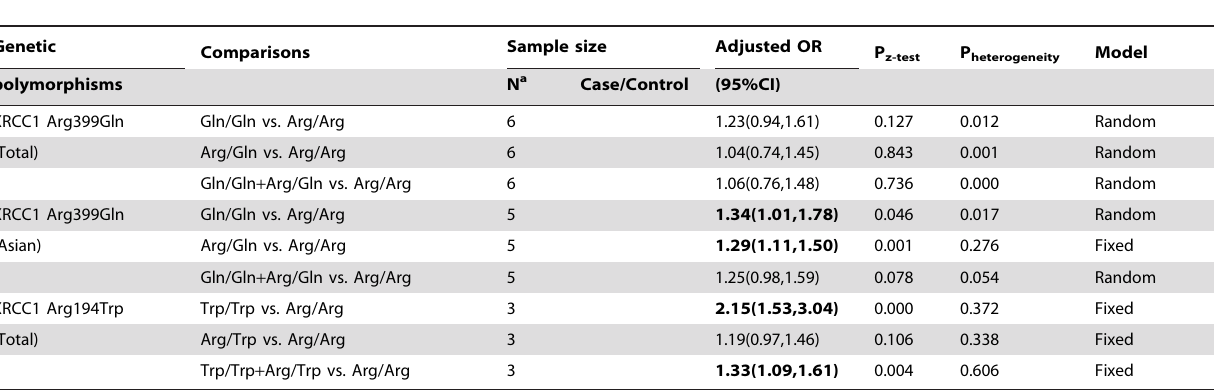
The statistical results still did not show publication bias (for XRCC1 Arg194Trp and Arg280His polymorphism were in Table 2; and for XRCC1 Arg399Gln polymorphism: Gln/Gln vs. Arg/Arg: Begg’s test P = 0.54, Egger’s test P = 0.32; Arg/Gln vs. Arg/Arg: Begg’s test P =0.06, Egger’s test P = 0.10; dominant Table 4. Quantitative analyses for the relationships between XRCC1polymorphisms and cervical cancer(CC) risk based on adjusted OR